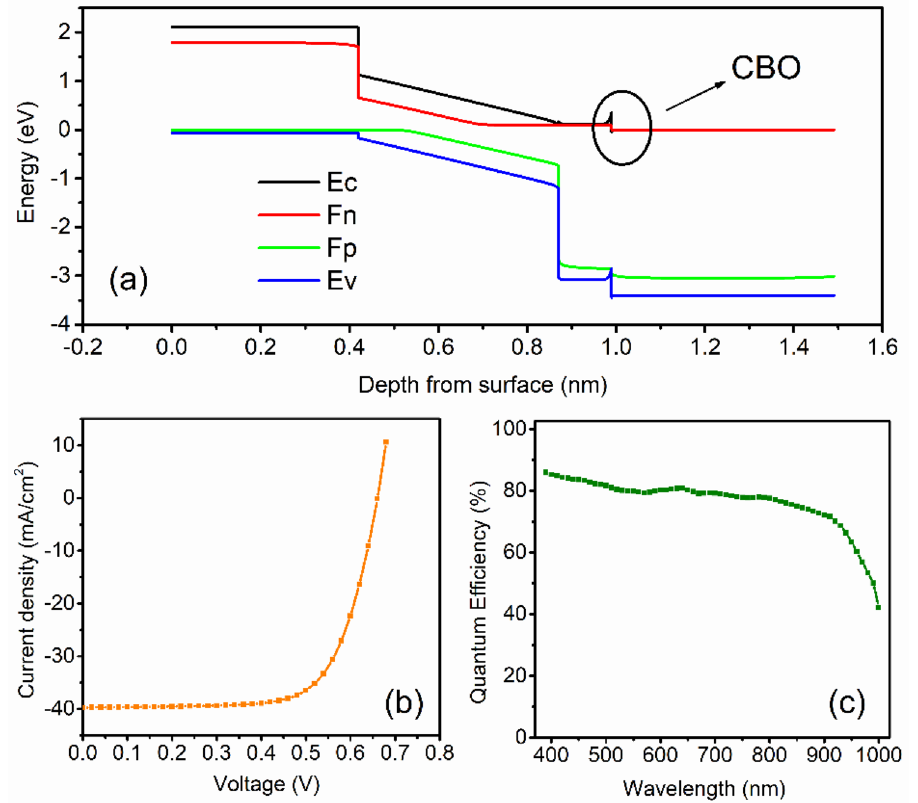
Figure 2. ( a ) Energy band diagram, ( b ) J sc and ( c ) quantum efficiency of